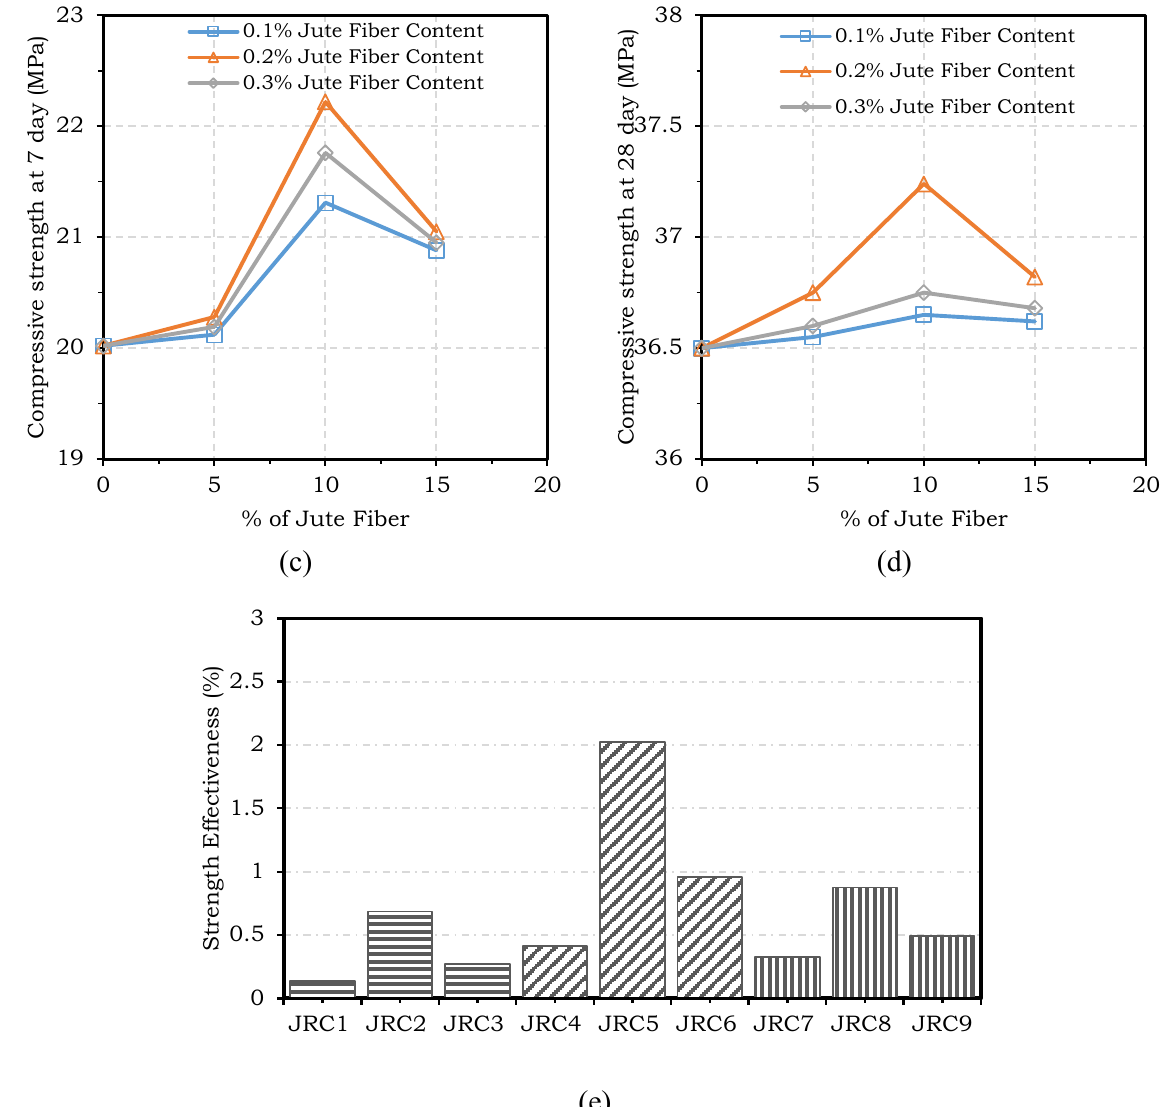
Fig. 5. Comparison of Compressive strength with (a) jute fiber (13 mm) for 7 days curing, (b) jute fiber (13 mm) for 28 days curing, (c) rice husk for 7 days curing, (d) rice husk for 28 days curing (e) Comparison of strength